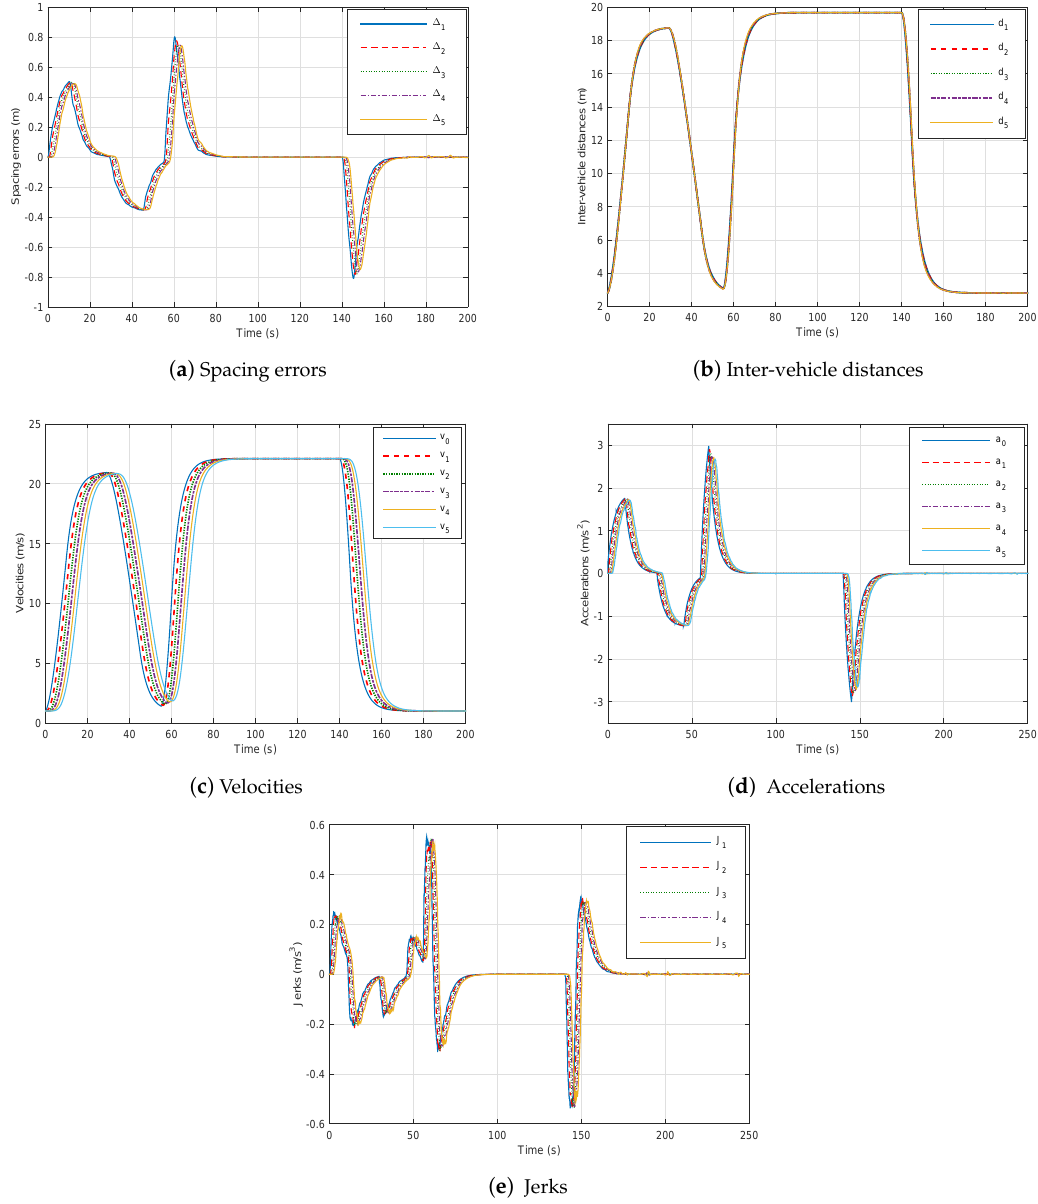
Figure 8. Six-vehicle platoon system under controller (47) through communication network with h d =